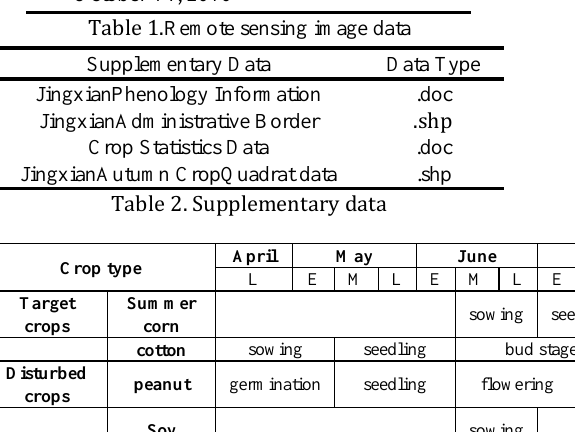
Table 1. Remote sensing image data